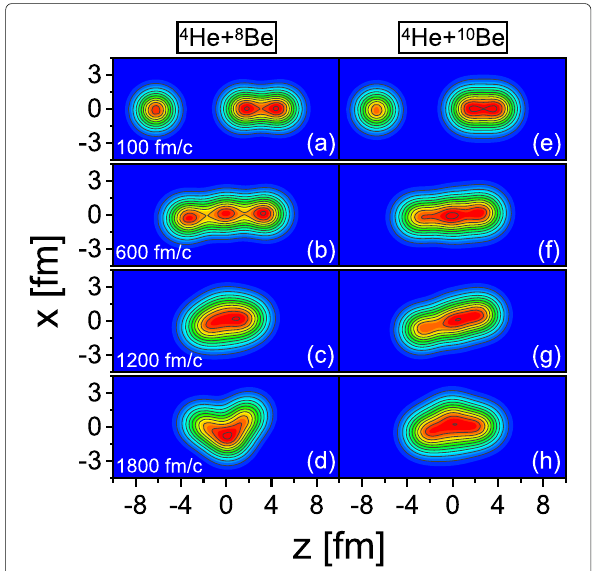
Fig. 5 Time evolutions of the total density distributions at the times t = 100, 1200, 3300, and 5000 fm/ c from the time-dependent CDFT for the 4 He + 8 Be (left) and 4 He + 10 Be (right) collisions with the impact parameter b = 0.1 fm